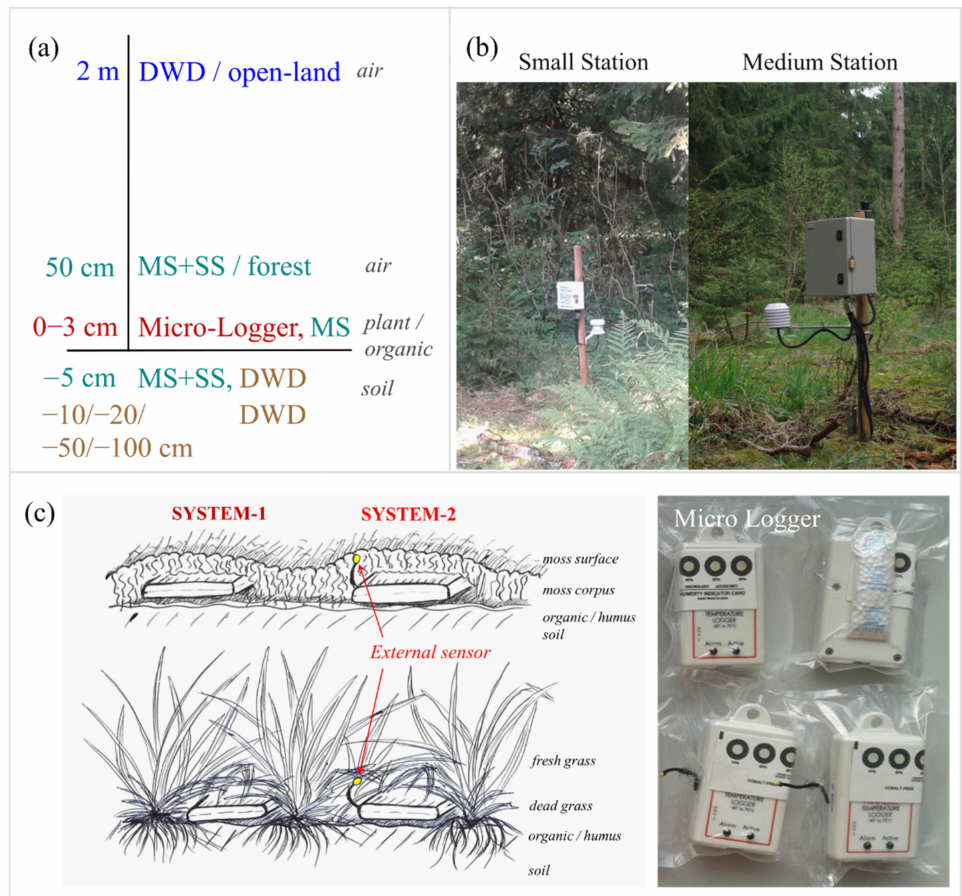
Figure 2. Features of the Micro-Loggers and climate stations in the forest (MS, SS) and the weather station of the German Weather Service (= Deutscher Wetterdienst, denoted as “DWD) ( a , b ); ( c ) illustrates the general measurement setup of the two Micro-Logger Systems 1 (internal sensor) and 2 (external sensor), which were located under moss ( top ) or grass ( bottom